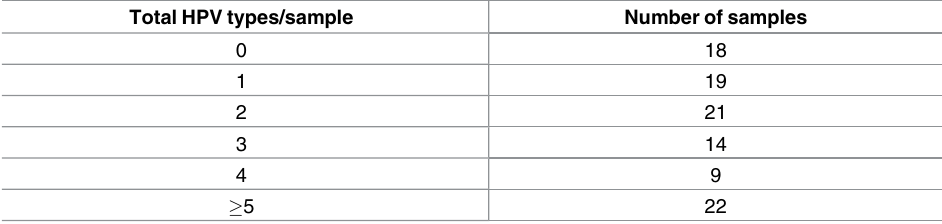
Table 3. Multiple HPV types detected in 103 urine